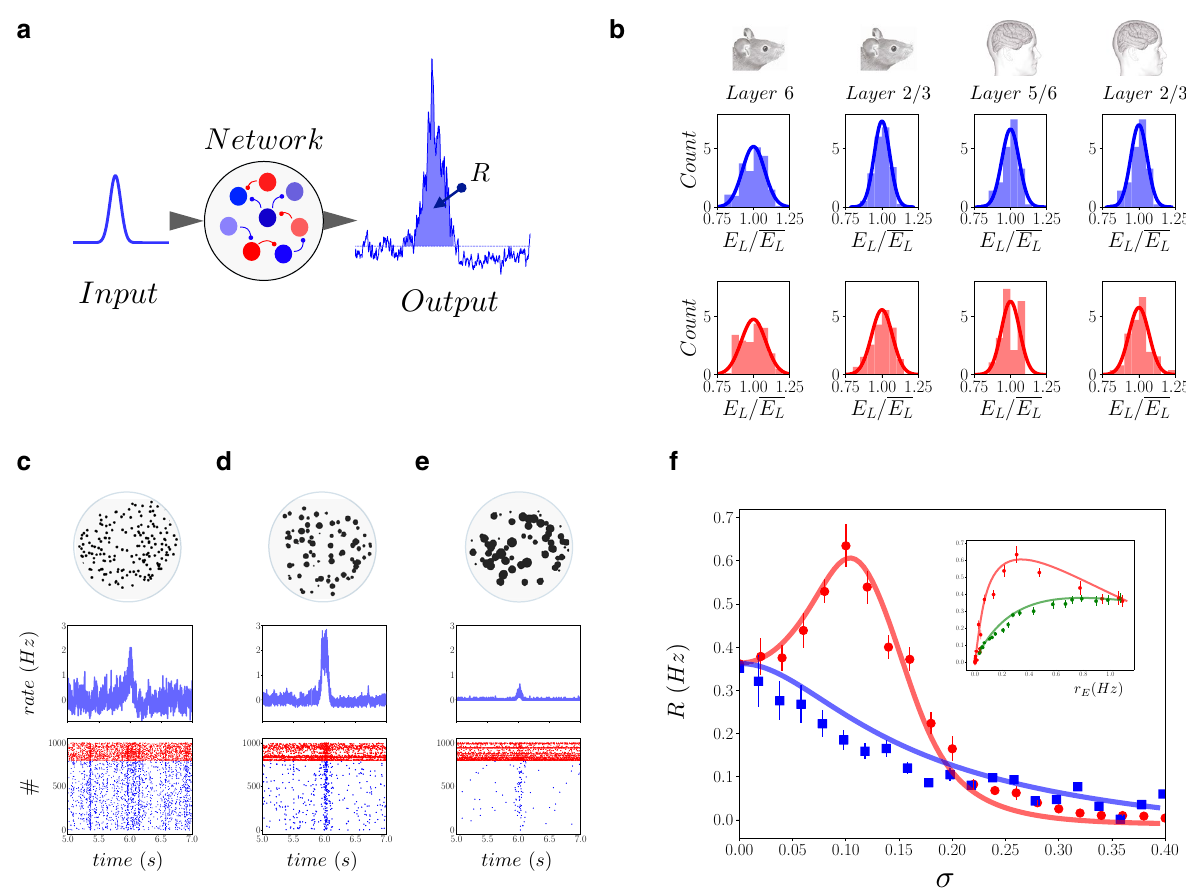
Figure 1. Inhibitory neuron heterogeneity optimizes network responsiveness. ( a ) An afferent excitatory input (Poissonian spike train at a time-dependent frequency ν ext ( t ) , Input ) was submitted to a network of excitatory and inhibitory neurons, whose population spiking activity (amount of spikes per time unit, Output ) is measured. The excess of activity in response to the input (blue area) measures the Responsiveness R of the network to the external stimulation. ( b ) Histograms of the resting potential e L = E L / E L of excitatoy (inhibitory) neurons in blue (red), top (low) row. Cells originate from the adult human brain, cortical layers 5/6 and 2/3, and mouse cortical layers 6 and 2/3 (Allen Brain Atlas 32 ). The continuous line is a Gaussian distribution with the same standard deviation as measured from the data. ( c ) Network activity in response to a time varying input ν ext ( t ) of amplitude A = 1 Hz and baseline value ν 0 = 1.5 Hz (see “Methods” section). Excitatory neurons population rate, normalised to pre-stimulus baseline activity, (top row, blue line) and the corresponding raster plot (bottom row), i.e. spiking times of excitatory (inhibitory) neurons marked with blue (red) dots. Panel ( c ) corresponds to an homogeneous network σ I = 0 , panel ( d ) to σ I = 0.1 and panel ( e ) to σ I = 0.15 (in these panels ( c )–( e ) σ E = 0 ). ( f ) The evoked response R is reported in function of the heterogeneity of inhibitory (excitatory) neurons σ = σ I ( σ = σ E ) , red (blue) dots (squares). Error bars are estimated as the standard deviation over 20 different realisations. Continuous lines report the prediction based on the mean field model (see main text). In the inset, R is reported in function of the spontaneous excitatory firing rate r E without the stimulus (average over 10 s). Red dots are obtained by varying σ I (same data as the main panel). Green dots show R in function of r E for an homogeneous network ( σ I = σ E = 0 ) and different values of the average resting potential of inhibitory neurons E I L Optimal responsiveness for heterogeneous networks. We studied networks of sparsely connected excitatory and inhibitory spiking neurons (see “Methods” for details). Each neuron receives afferent excitatory spike trains at a frequency ν ext ( t ) . To characterise the responsiveness of the network to external stimulation, we considered ν ext ( t ) composed by a time constant baseline value ν 0 and a time variation of amplitude A (see “Meth- ods”, Input in Fig. 1a). The network responds to the stimulation by increasing its population spiking activity (see Output in Fig. 1a). The network responsiveness R can be estimated as the total amount of evoked spikes by the whole network (see the blue area in the Output of Fig. 1a). We compared homogeneous networks to networks constructed from measurements in the adult human and mouse brain from the Allen Brain Atlas 32 . In Fig. 1b, we report the histogram of the resting membrane potential E L measured experimentally from excitatory (blue, top panels) and inhibitory neurons (red, lower panels) in human and mouse cortical layers. By calling E L the average value of E L , one can see a heterogeneous distribution of the re-scaled resting potential e L = E L / E L . The distribu-